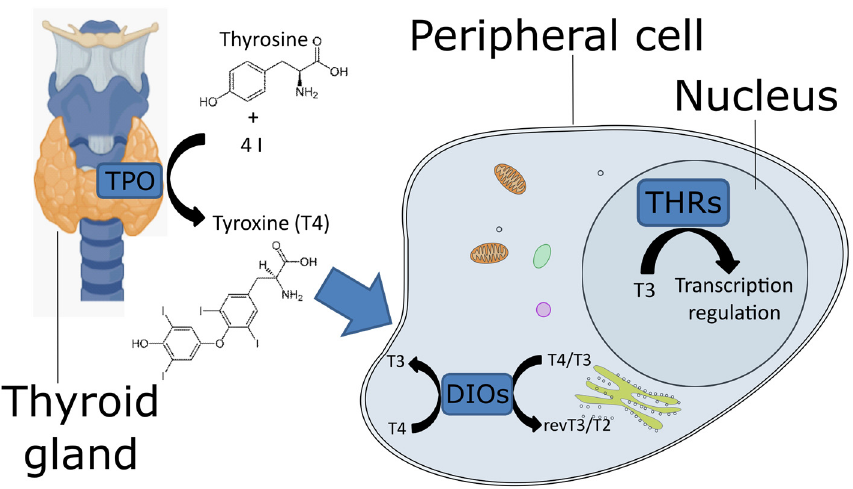
Figure 1. Diagram representing the thyroid hormone signaling system. The thyroid drawing was taken from BioRender (https://biorender.com/, access date 15 September 2021), and the stylized cell was drawn starting from the animal cell clipart (https://svg-clipart.com/cartoon/lCu7ktQ-animal-cell-clipart, access date 15 September 2021).